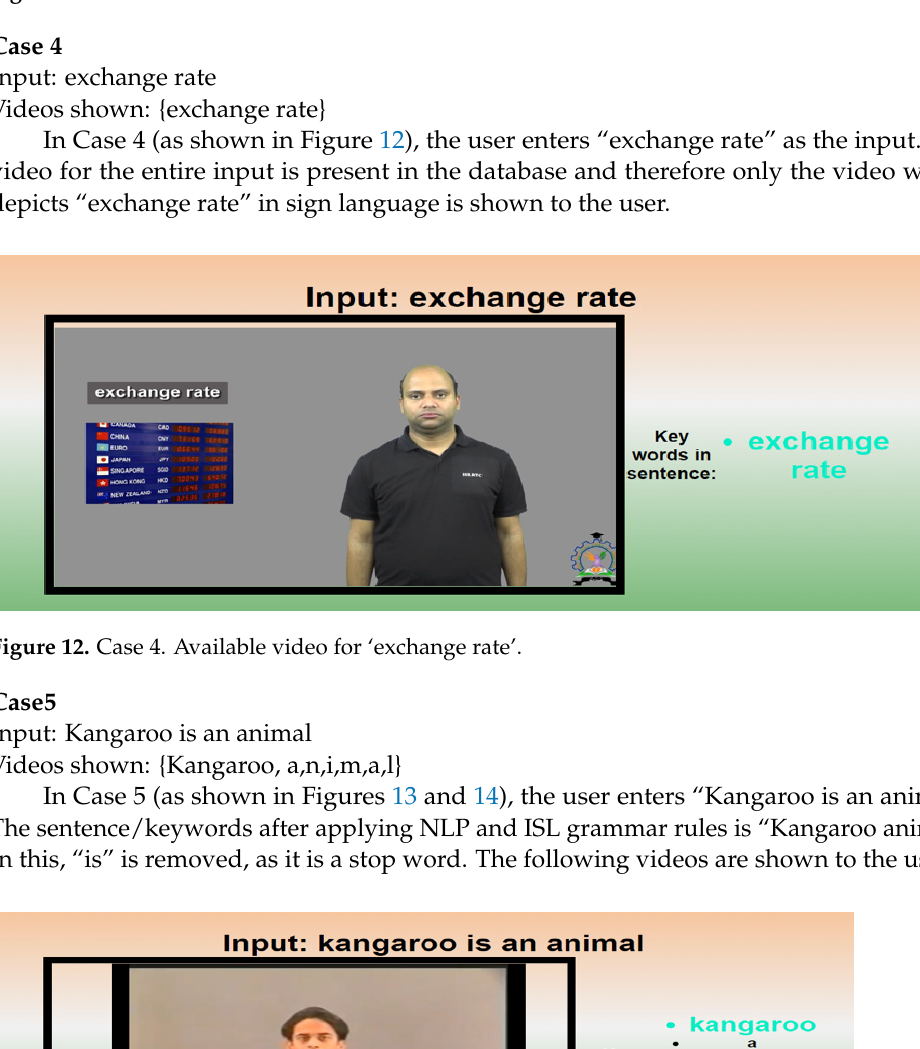
Figure 11. Case 3. Available video for letter ‘a’.